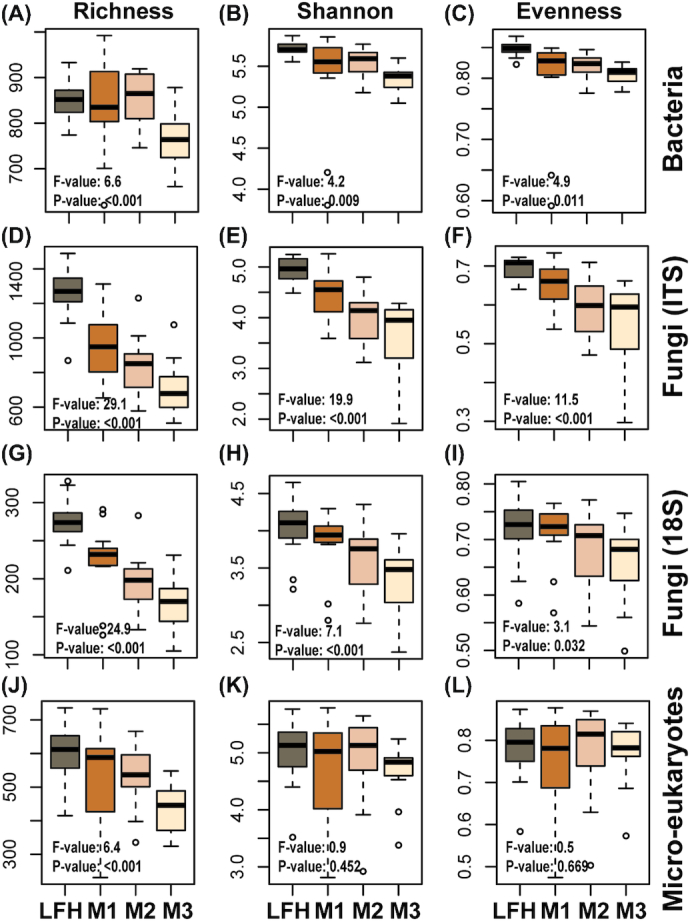
Boxplots showing soil depth related diversity patterns for different microbial groups. Diversity measure such as richness, Shannon index and evenness are shown for bacteria (16S; A–C), fungi (ITS: d-f; 18S: G–I), and micro-eukaryotes (18S: K–L) are shown. Samples were collected along a soil depth gradient (forest floor (LFH) and three mineral soil layers: 0–5 cm (M1), 5–15 cm (M2), 15–30 cm (M3)) from natural birch forest. Statistically significant differences among soil depth were analysed using ANOVA and Tukey's post-hoc test.